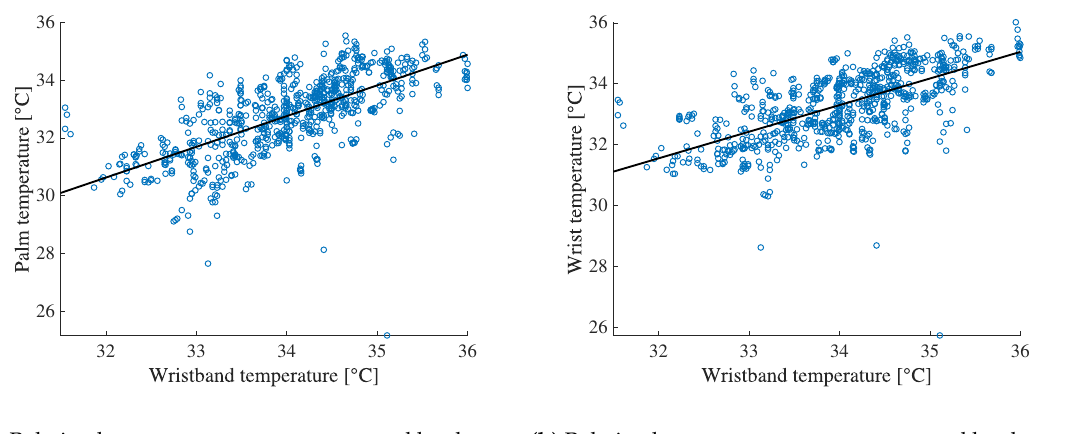
(a) Relation between temperature measured by the (b) Relation between temperature measured by the wristband and palm temperature. wristband and temperature around the wristband. Figure A1. Relation between temperature measured by the the wristband and thermal